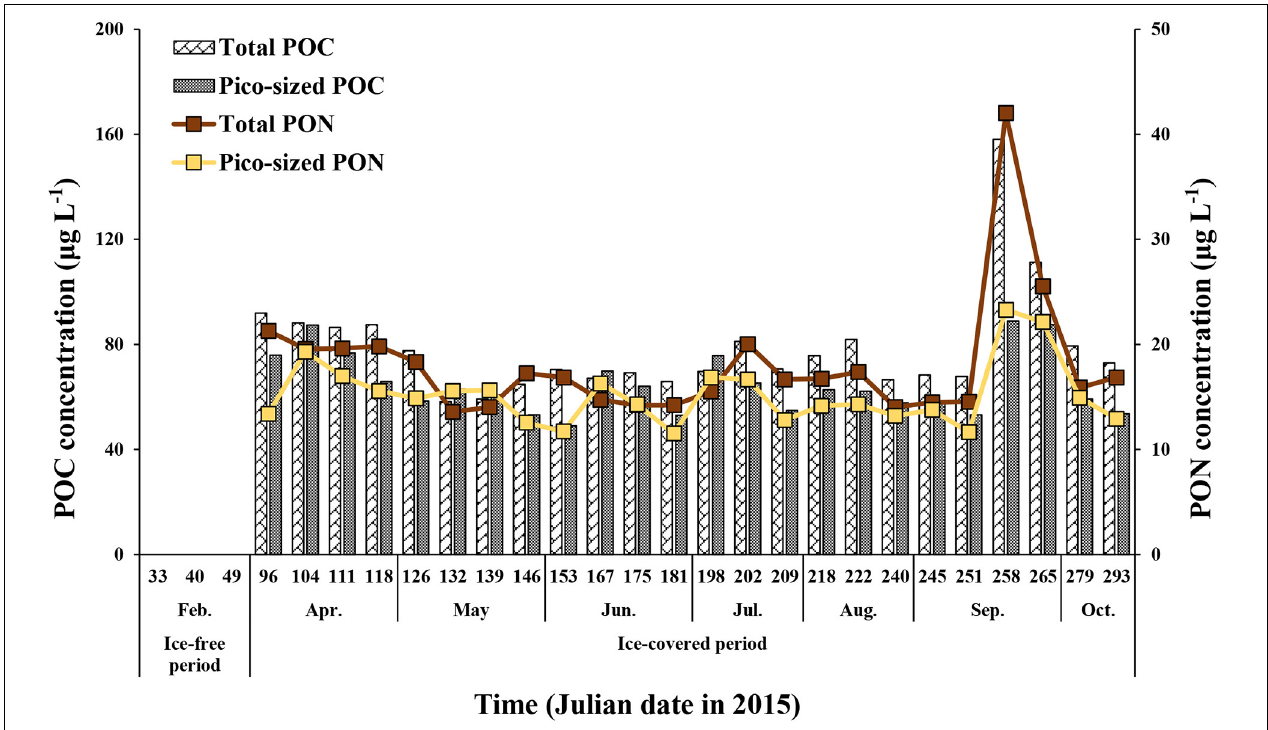
FIGURE 2 | The total ( > 0.7 µ m) and pico-sized (0.7–2 µ m) POC and PON concentrations at JBS during the ice-covered period, 2015.